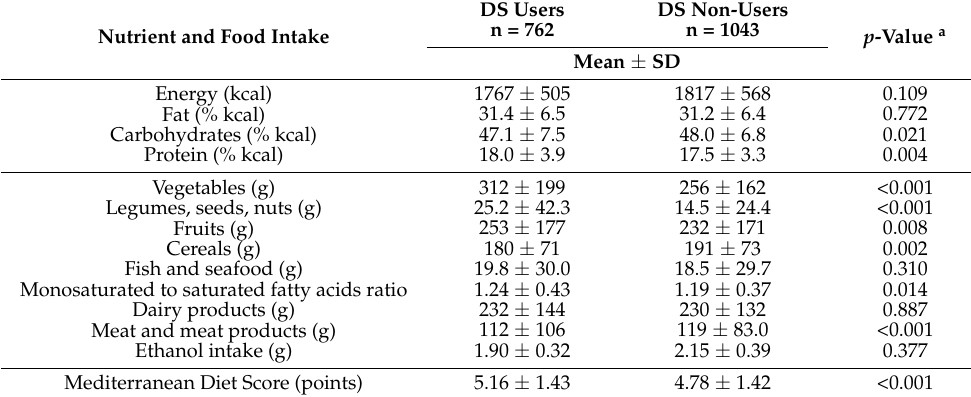
Table 4. The mean daily energy, nutrients, and food consumption among university students by using dietary supplements (DS) (n =